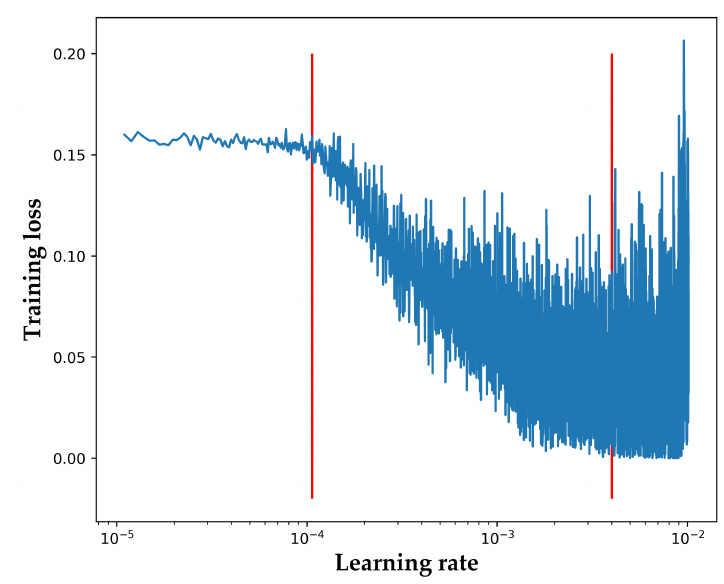
Figure 6. Relationship between network loss and learning rate.